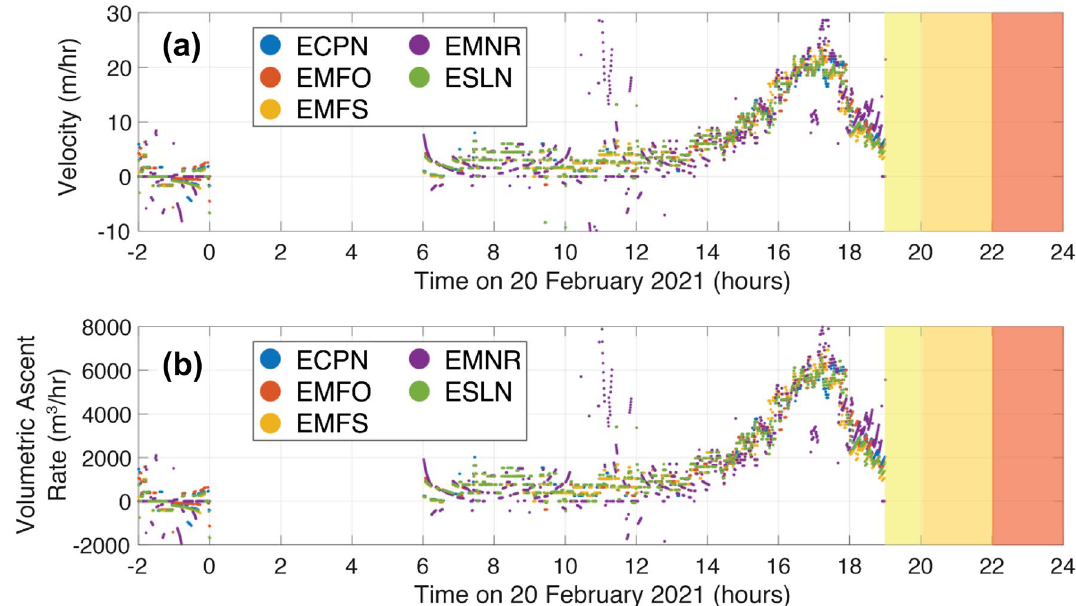
Figure 9. ( a ) Magma ascent rate (m/hr) and ( b ) volumetric ascent rate (m 3 /hr) for the five infrasound stations with the best signal-to-noise ratio; (blue) ECPN, (red) EMFO, (yellow) EMFS, (purple) EMNR, and (green) ESLN. Colored boxes indicate different phases of the eruption: (yellow) weak Strombolian activity, (orange) strong Strombolian activity, (red) lava